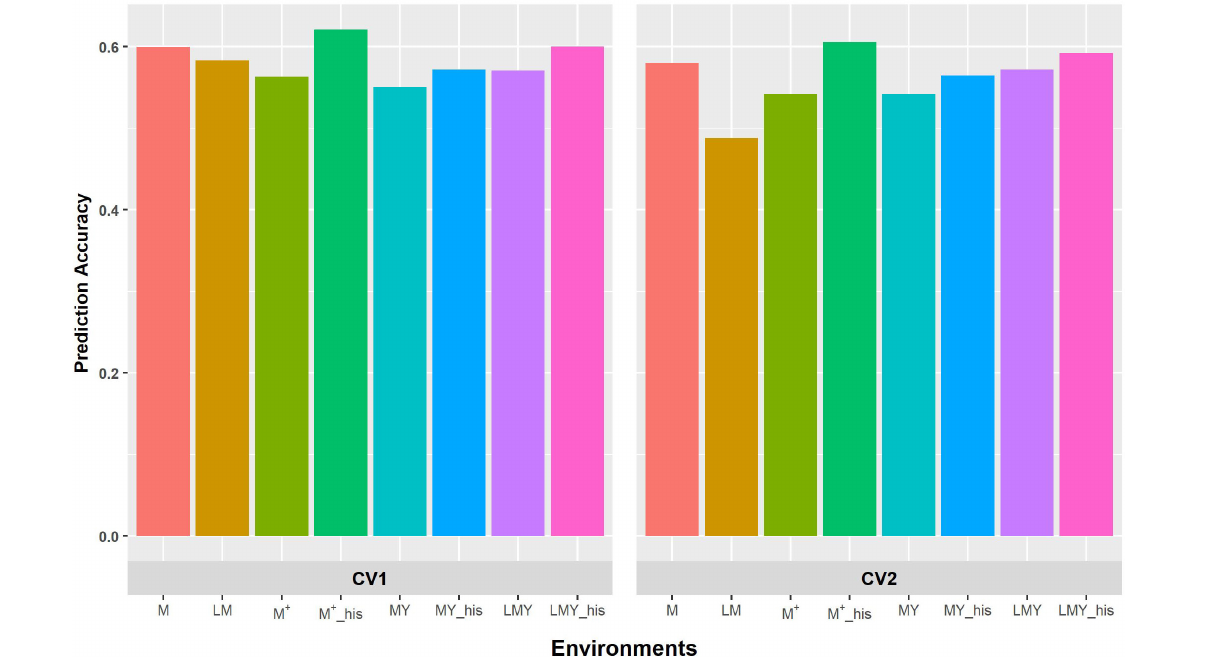
Schopp et al., 2017; Atanda et al., 2020) also indicate